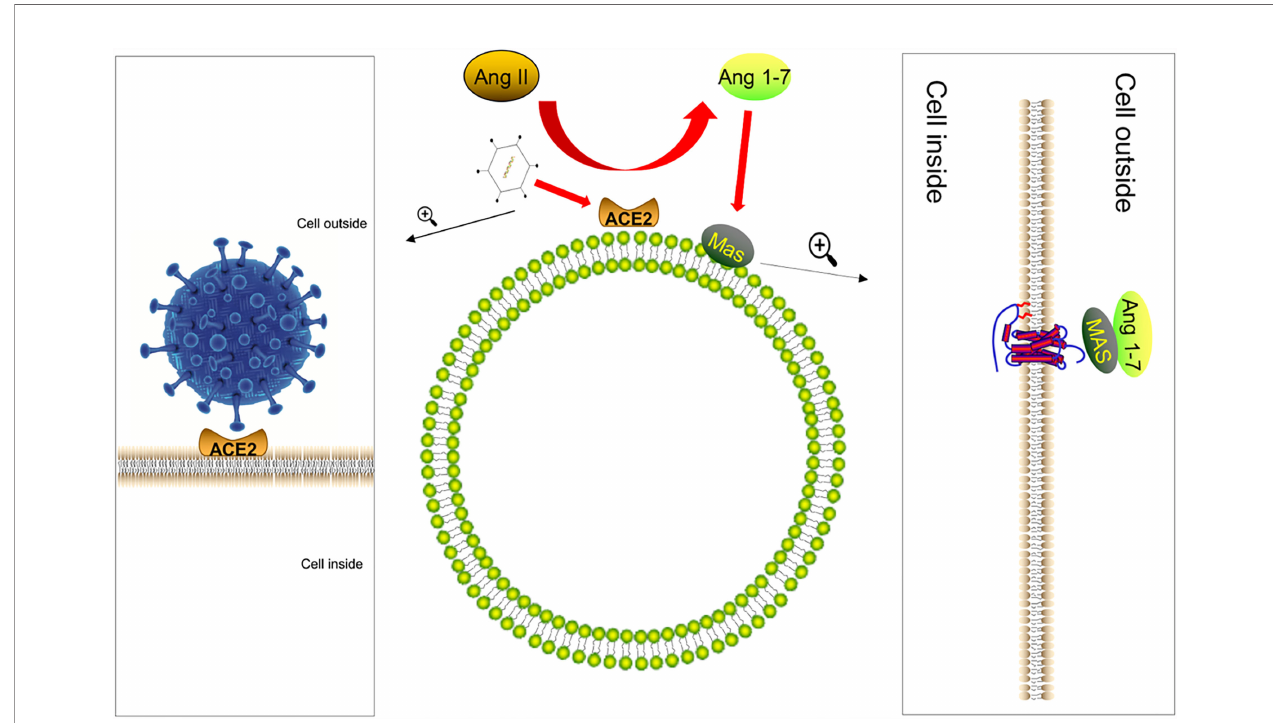
FIGURE 1 | The S protein of COVID-19 infects the host by combining with ACE2. After the virus infects the host, the expression of ACE2 protein is downregulated. ACE2 converts Ang II, the main biologically active molecule of RAS, to Ang 1-7; Ang (1Mel7) has anti-in fl ammatory and anti-remodeling effects after binding to the Mas receptor and coupling with Gq protein. Therefore, after the virus infects the host, it is likely to cause the intestinal anti-in fl ammatory ability to